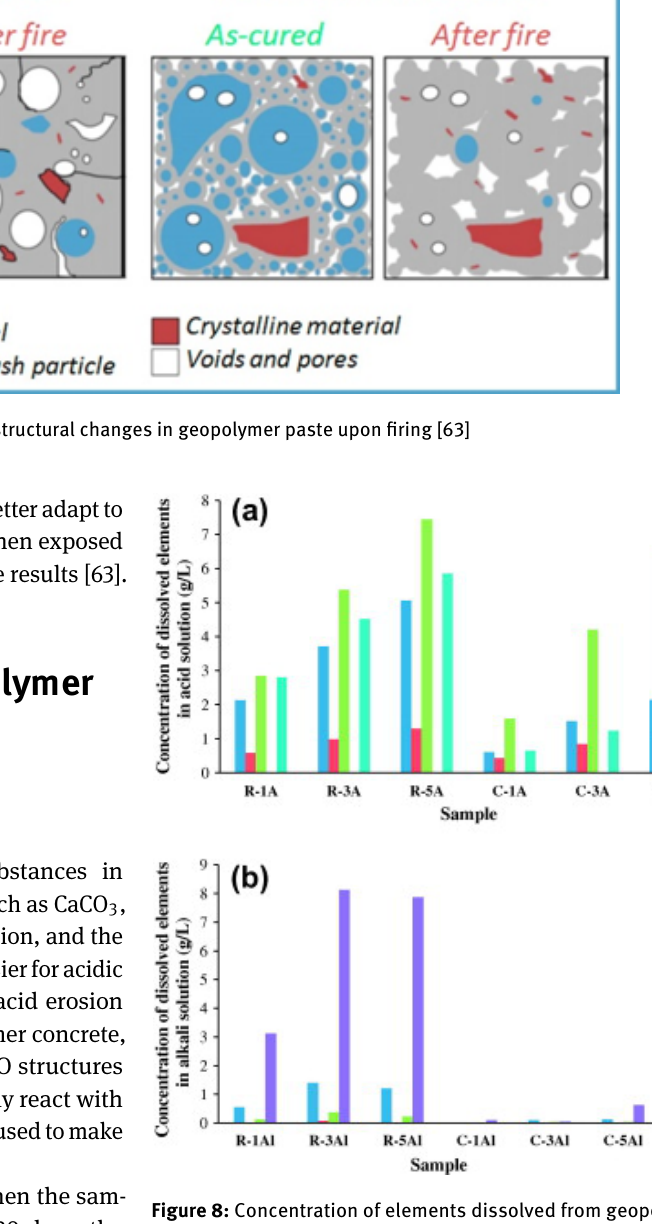
ash-based geopolymer slurry was placed in a 5% H 2 SO 4 and 5% acetic acid solution, the performance was superior to ordinary Portland cement slurry. The formation of zeo- lites and depolymerization aluminosilicate network were closely related to the deterioration in the pastes